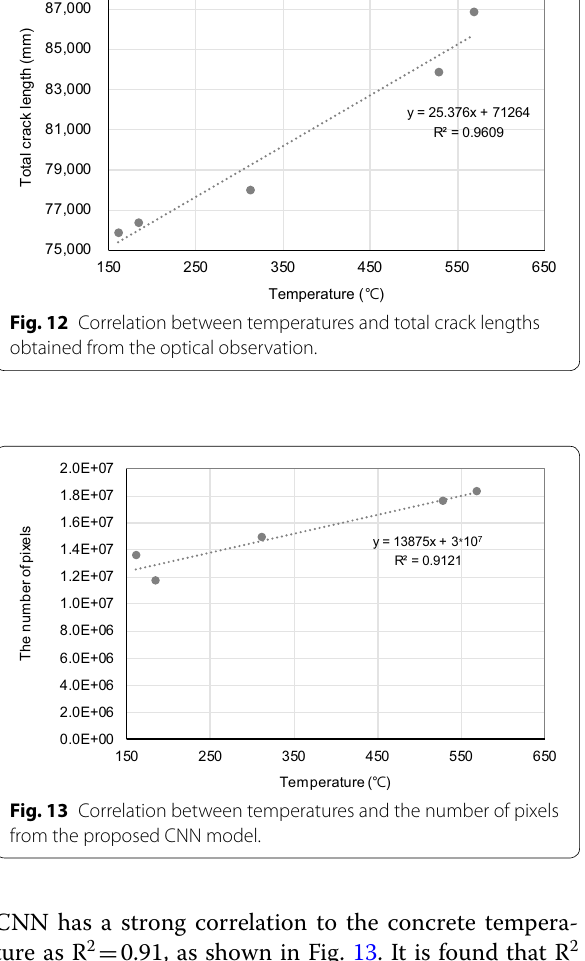
Fig. 13 Correlation between temperatures and the number of pixels from the proposed CNN model.